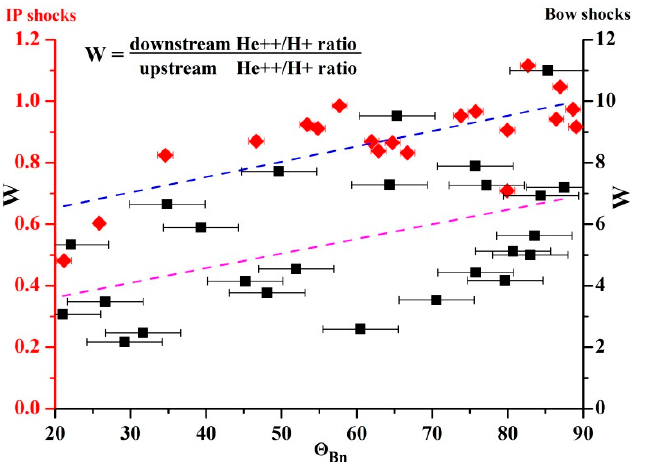
Figure 8. Dependence of the change in helium abundance N α /Np on the angle θ Bn at the intersection of the shock fronts. The red symbols show the events of the IP shock front crossings, and the black symbols show the Earth’s bow shock front crossings. The blue dashed line shows the trend for the first set, and the purple dashed line shows the trend for the second set. The errors in the values of the angle θ Bn are shown by bars.